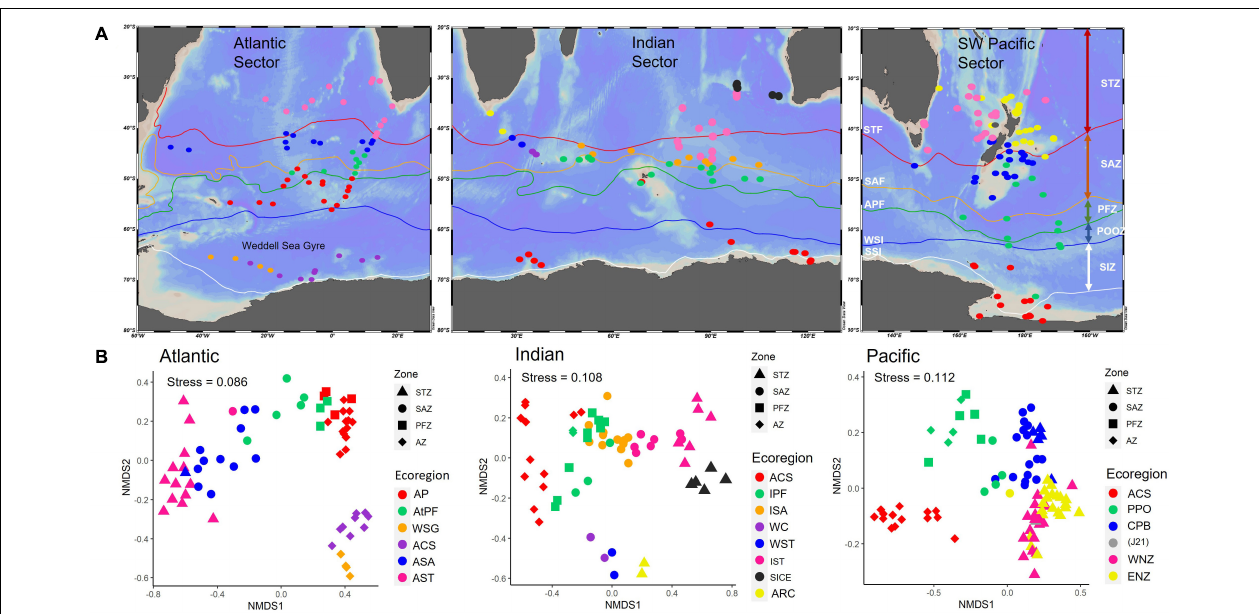
FIGURE 4 | (A) Maps show the distribution of sites within ecoregions identified by the MRT analysis for each Sector. STF, Subtropical Front; SAF, Subantarctic Front; APF, Antarctic Polar Front (Orsi et al., 1995); STZ, Subtropical Zone; SAZ, Subantarctic Zone; PFZ, Polar Frontal Zone; POOZ, Permanently Open Ocean Zone; SIZ, Seasonal Sea-Ice Zone; WSI, Winter Sea-Ice Margin; SSI, Summer Sea-Ice Margin. (B) 2-dimensional NMDS plots for Hellinger transformed radiolarian assemblage data at sites of the SO-RAD dataset south of 30 ◦ S for the Atlantic, Indian and Pacific Sectors. Color represents the ecoregions identified by MRT analysis; shapes represent the zone: STZ, Subtropical Zone; SAZ, Subantarctic Zone; PFZ, Polar Frontal Zone; AZ, Antarctic Zone. Pease see Supplementary Figure 2 for a color blind alternative.